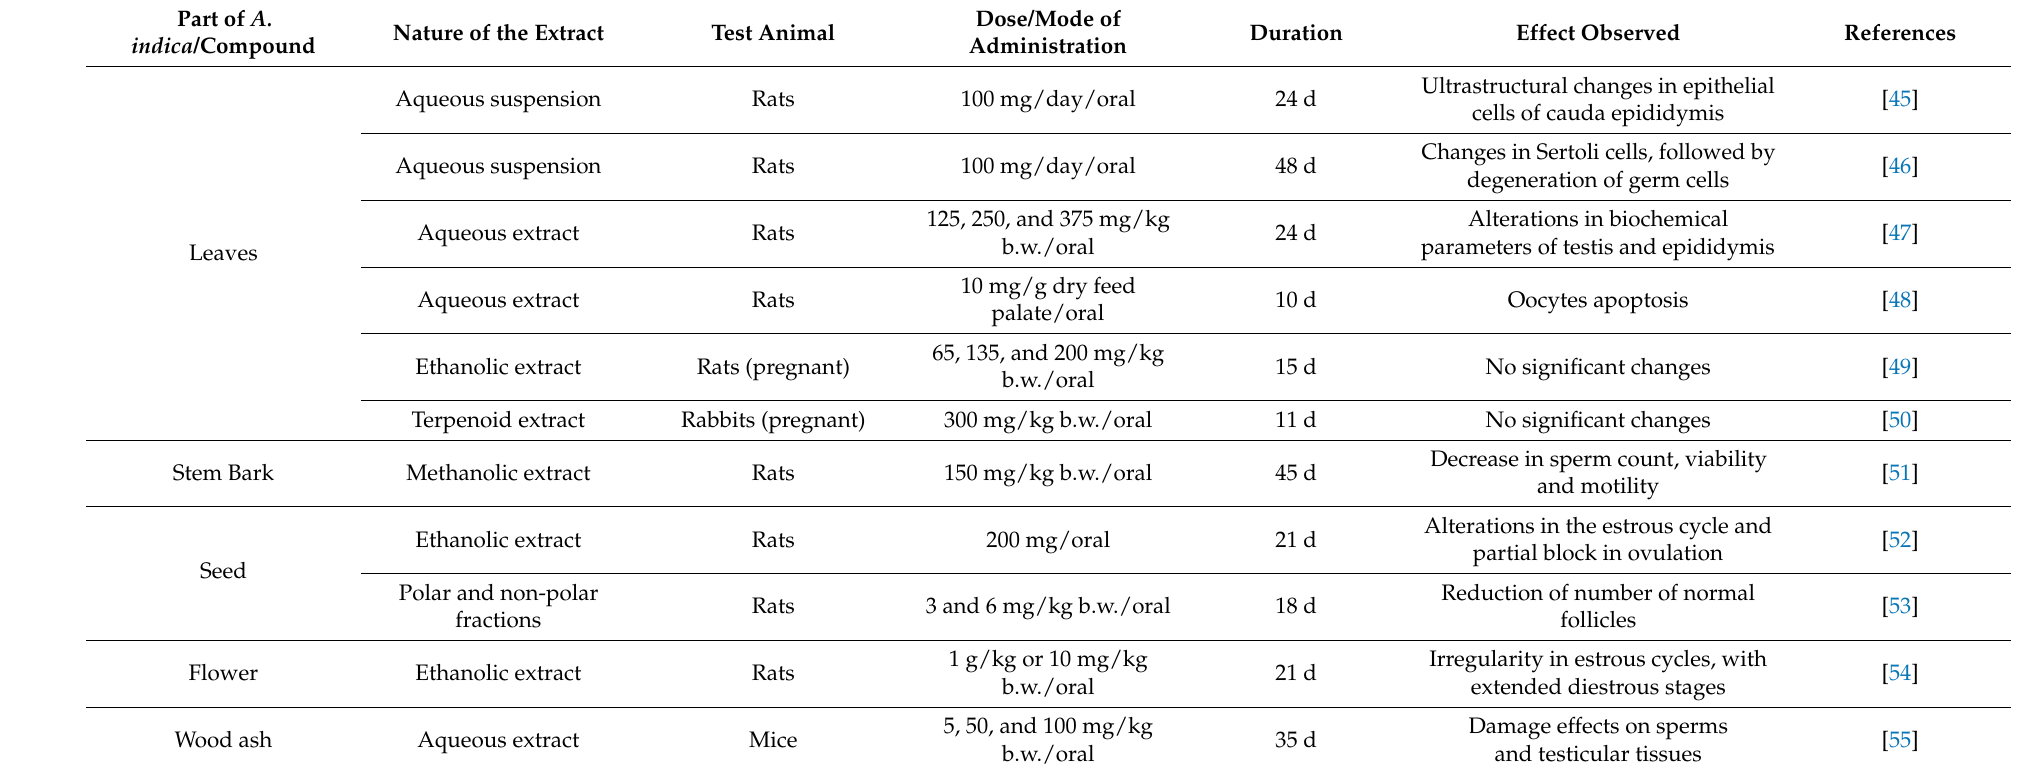
Table 5. Reproduction and teratogenicity effect of neem in different mammalians.